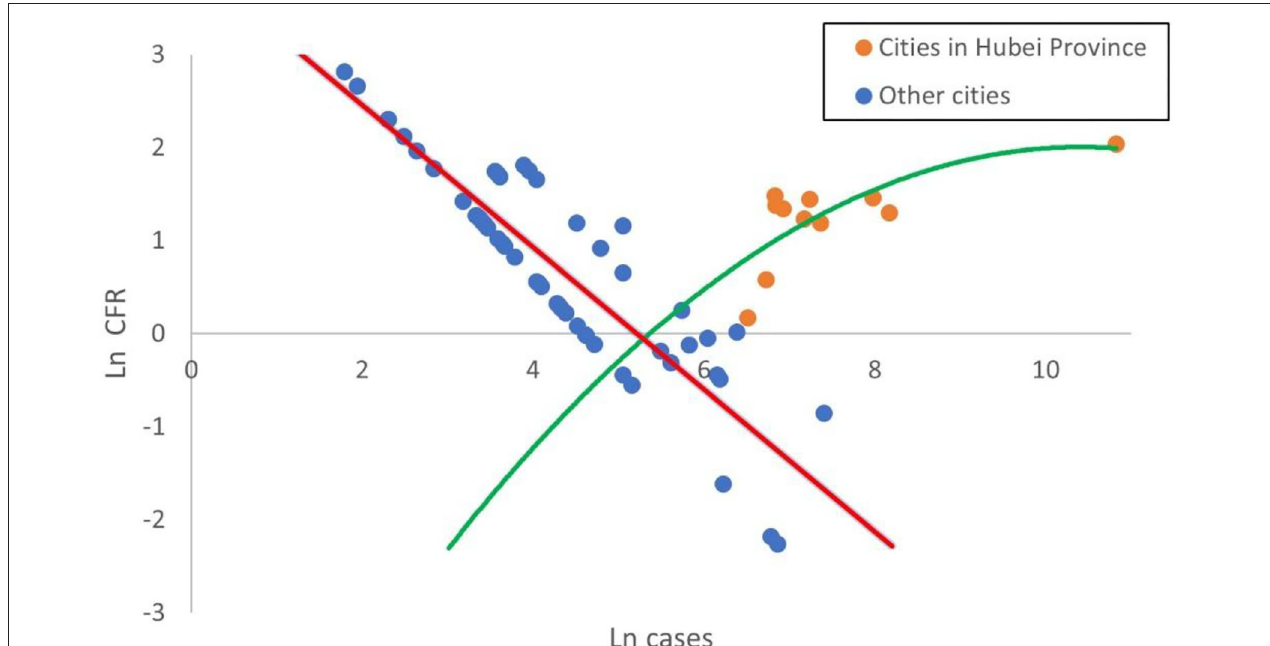
FIGURE 3 | Scatterplot of COVID-19 ln CFR against ln cases.